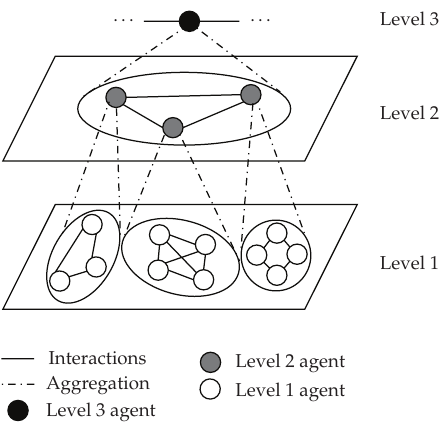
Figure 2: Hierarchical swarm optimization model using a multiagent system in nested